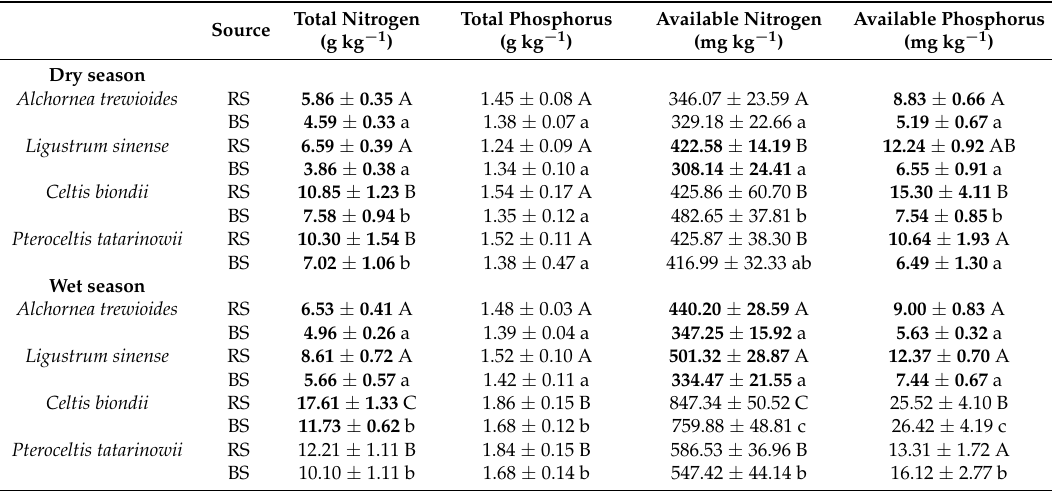
Table 1. Nitrogen and phosphorus concentrations and availabilities in rhizosphere and bulk soils of the four study plant species in a karst ecosystem of southwest China (mean ± SE).